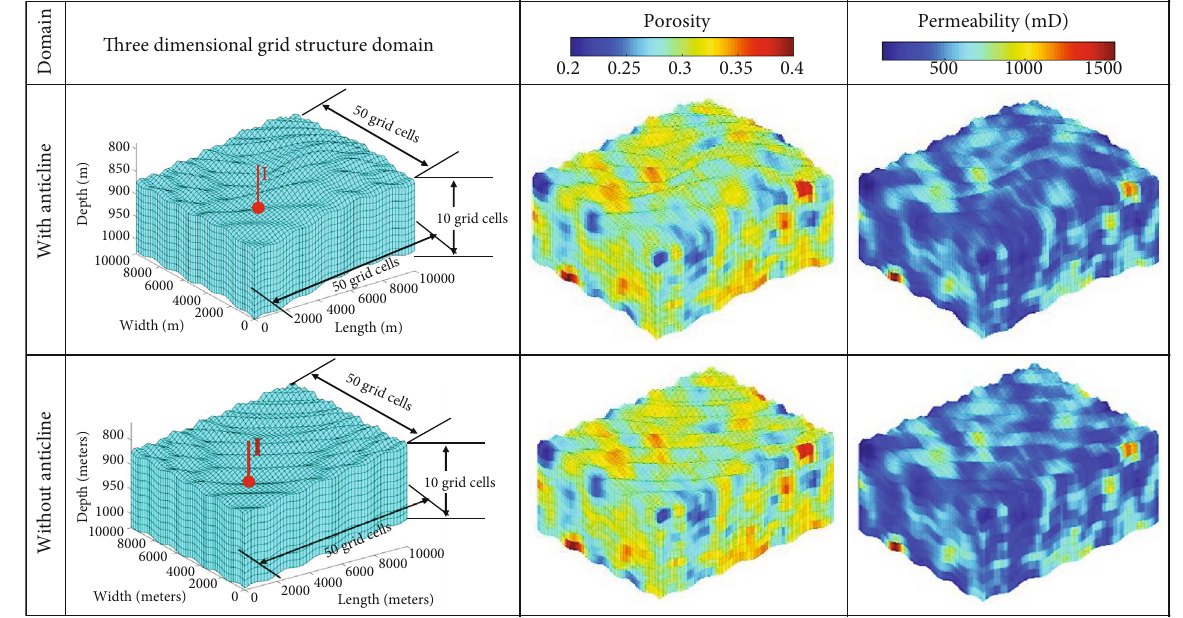
Figure 2: Illustration of a schematic diagram of the three-dimensional grid structure of both the domains and petrophysical properties distribution. Table 2: Solubility trapping reactions with respective Log(K) values at standard temperature (25 ° C).